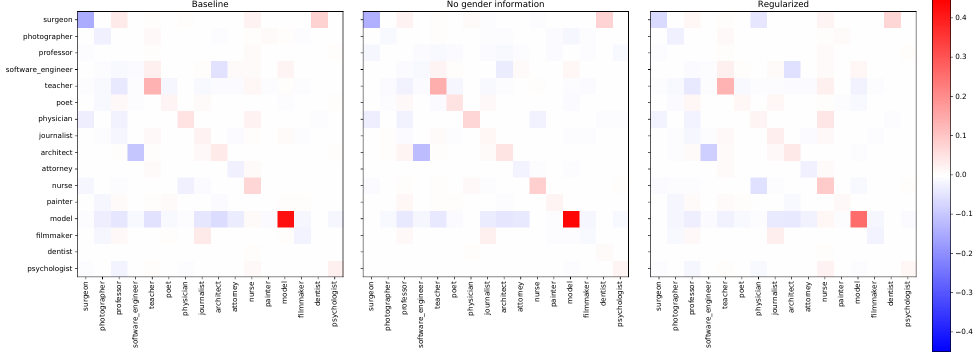
Figure A1. Extension of Figure 2 to all output classes of the Bios dataset and not only the most- frequent ones, which were selected in Figure 2 for readability purposes.